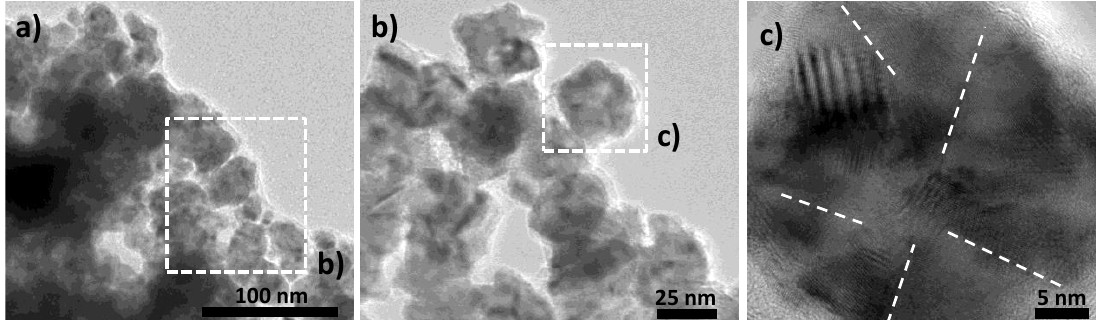
Figure 3. ( a ) Transmission electron microscopy (TEM) micrograph of the as-produced Ni powder. Only one population of particles can be identified: almost isotropic in shape polycrystals of 25–30 nm in size ( b , c ). More or less amorphous thin Ni hydroxide veils appear time to time around the Ni particles as a residual synthesis product ( b ). Note the white dashed lines are just guidelines.